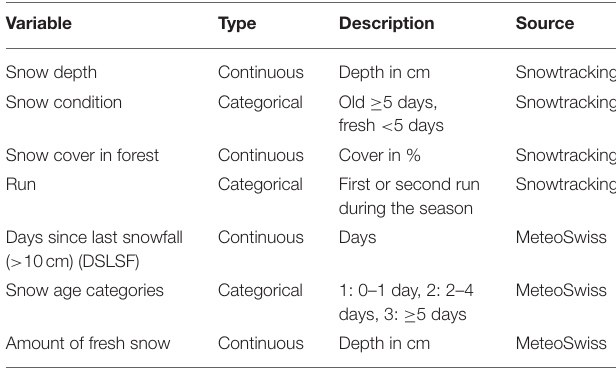
TABLE 3 | Snow variables used for predicting the detection probability of ungulates based on snowtracking survey